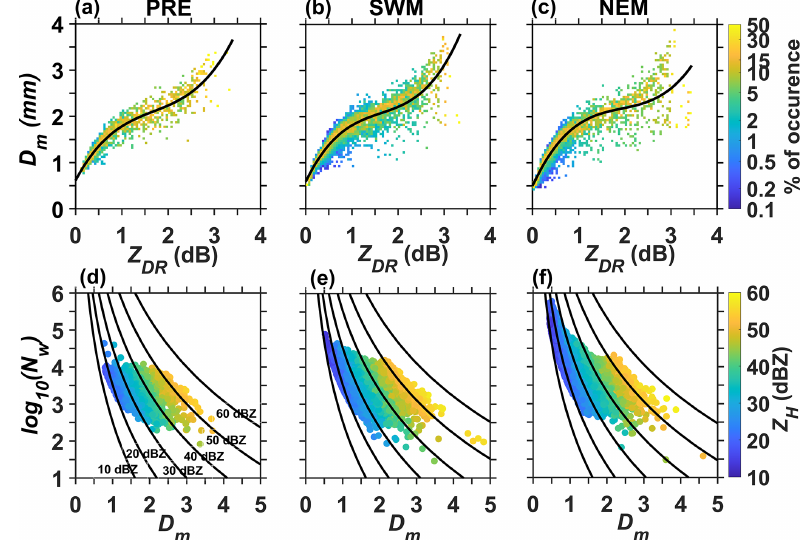
Figure 4. Scatter plots between Z DR and D m for the (a) PRE, (b) SWM and (c) NEM seasons. The solid line is the third-order polynomial fit (Eq. 15). (d–f) Scatter plots between log (N W ) and D m as a function of Z H for PRE, SWM and NEM, respectively. The solid lines indicate the variation of log (N W ) with D m for different Z H values, estimated using appropriate coefficients obtained with Eq. (16).